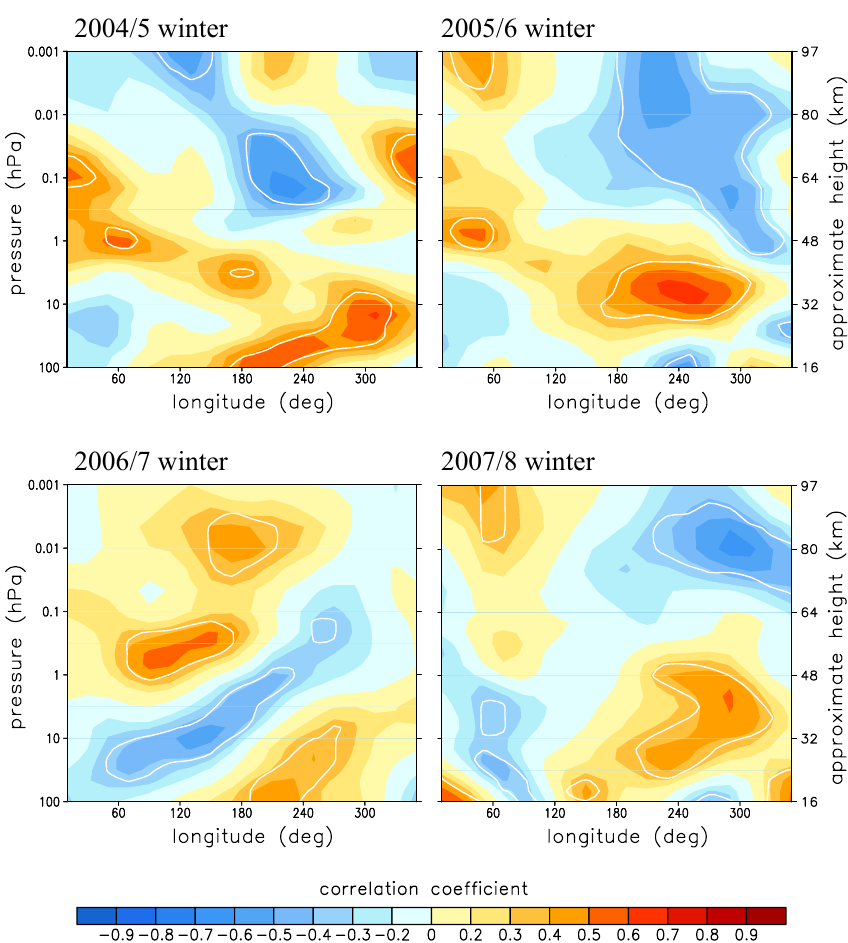
Fig. 14. Correlation coefficient for temperature over 60–65 ◦ N at each longitude/pressure with respect to zonal mean temperature at the Antarctic summer mesopause ( ∼ 0.002hPa, 80–85 ◦ S, position cannot be marked in this figure). The white line indicates the 95% level of significance. Time lags are applied based upon the results from Fig. 12. See text for